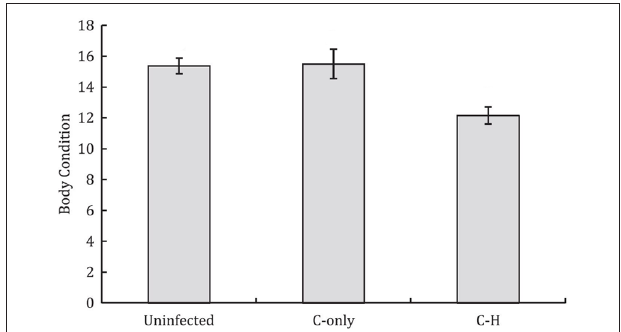
figURe 6 | Buffalo coinfected with two gastrointestinal parasites ( Cooperia-Haemonchus ) exhibit lower body condition compared to uninfected and Cooperia -only singly-infected buffalo (means ± SE are shown). [Adapted from ( 45 ), under creative commons